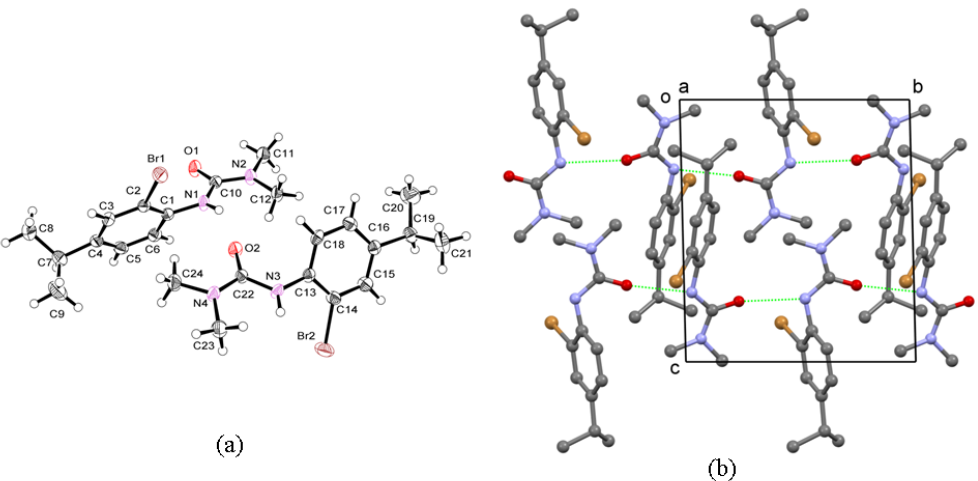
Figure 3. ( a ) An ortep representation of the asymmetric unit of 2 showing the two molecules in the asymmetric unit; ( b ) Crystal packing viewed down the a axis with the hydrogen atoms omitted for clarity. Hydrogen bonds are shown as dashed lines.